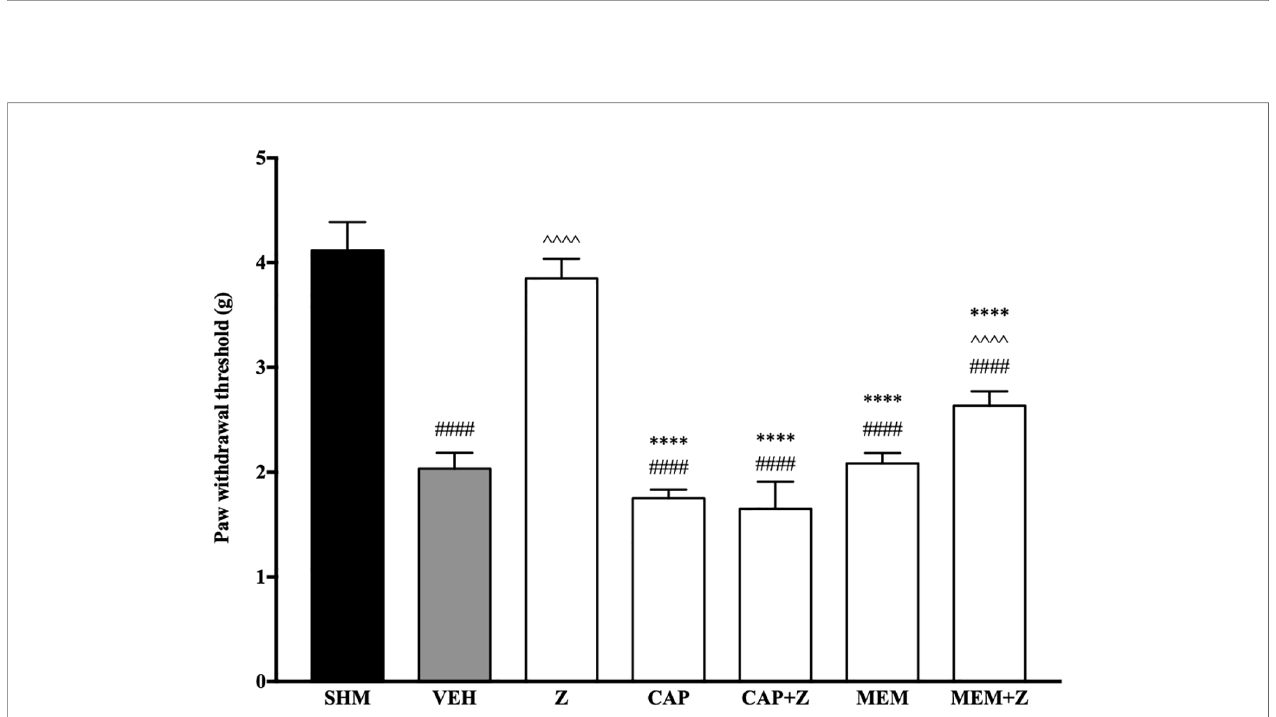
FIGURE 8 | Effect of capsazepine (TRPV1 antagonist) and memantine (NMDA antagonist) pre-treatment on zerumbone against mechanical allodynia in CCI-induced neuropathic pain mice. Data are presented as mean ± SEM (n = 6). #### p < 0.0001 as compared to sham, ^^^^ p < 0.0001 as compared to vehicle and **** p < 0.0001 as compared to zerumbone-treated group. SHM (Sham); VEH (Vehicle, 10 mL/kg i.p.); Z (Zerumbone, 10 mg/kg i.p.); CAP (Capsazepine, 10 mg/kg i.p.); MEM (Memantine, 10 mg/kg